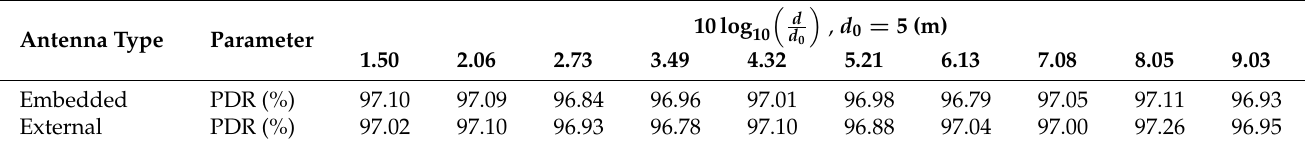
Table 4. Packet Delivery Ratio (PDR) for the Non-Line-of-Sight